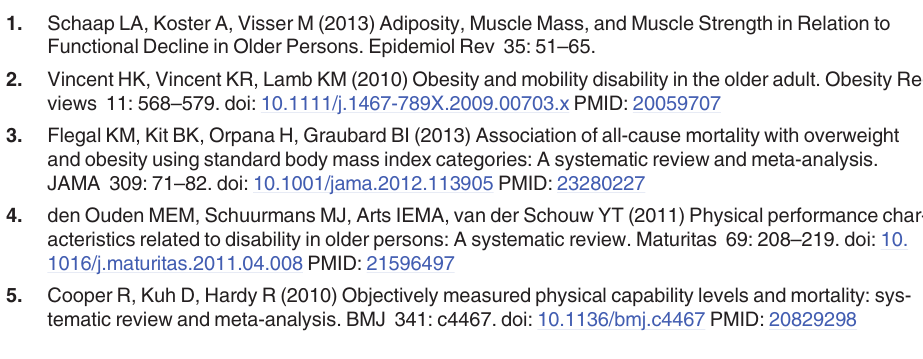
S1 Table. Frequency of participation in sedentary behaviors and physical activities assessed using the Community Health Activities Model Program for Seniors physical activity ques- tionnaire. S2 Table. Mean differences in body mass index (kg/m 2 ) per hour/day increase in self- reported sedentary behaviors (n = 1193). S3 Table. Mean differences in waist circumference (cm) per unit increase in physical activi- ty and sedentary